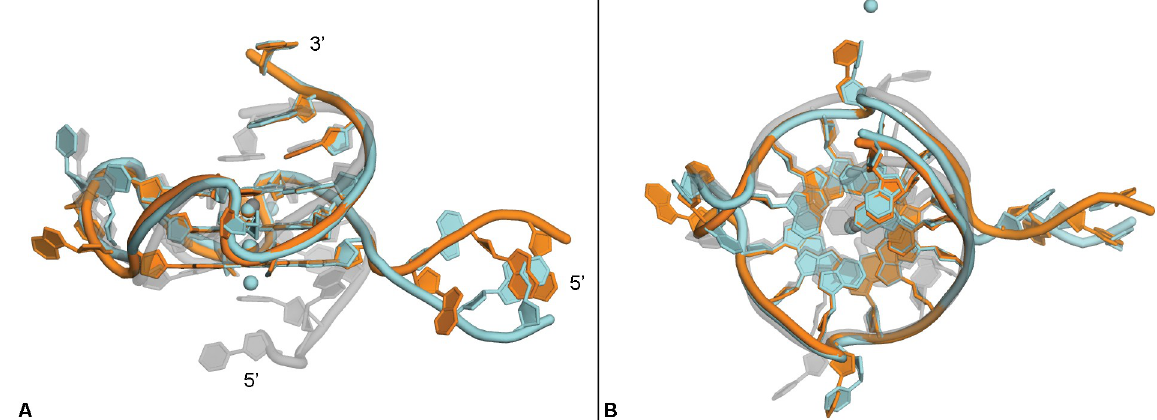
Fig 6. Comparison to NMR solution structure. Overlay of NMR solution structure (PDB:1XAV, grey) with strand A (orange) and strand B (cyan) of the c-MYC promoter crystal structure, side view (A), top view (B).